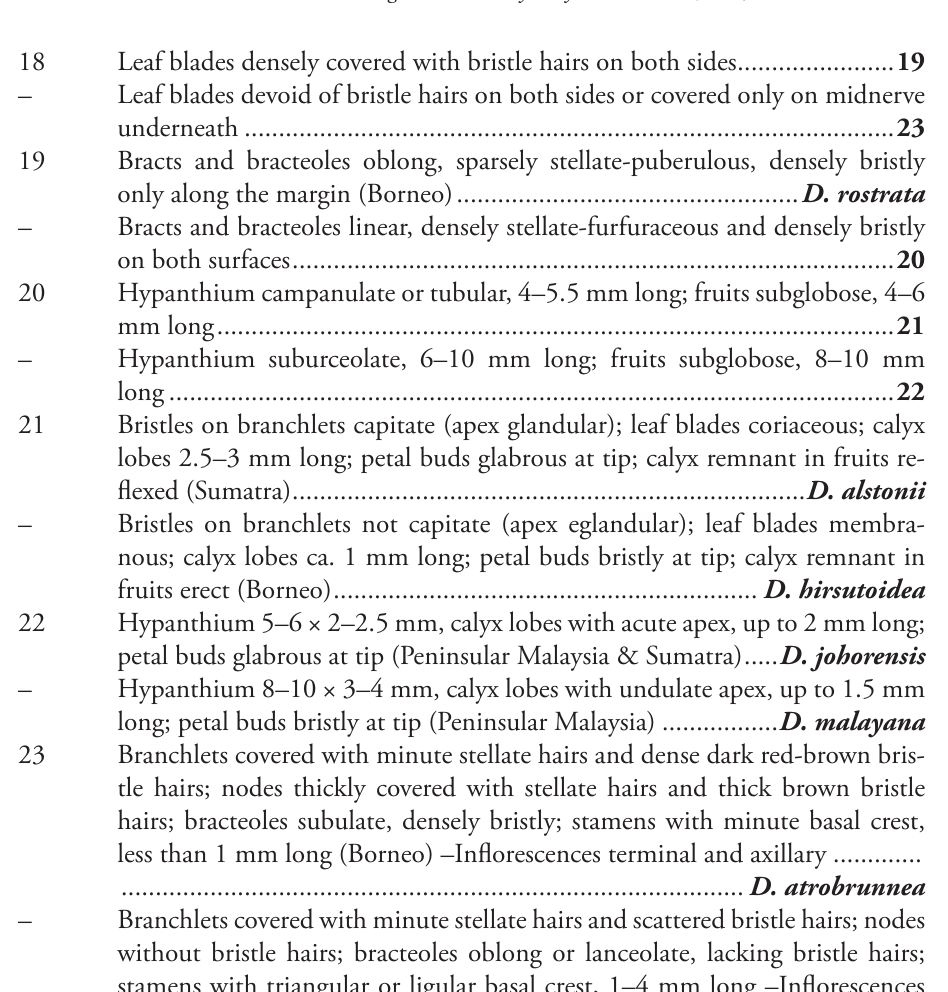
Leaf blades devoid of bristle hairs on both sides or covered only on midnerve Bracts and bracteoles oblong, sparsely stellate-puberulous, densely bristly – Bracts and bracteoles linear, densely stellate-furfuraceous and densely bristly 20 Hypanthium campanulate or tubular, 4–5.5 mm long; fruits subglobose, 4–6 – Hypanthium suburceolate, 6–10 mm long; fruits subglobose, 8–10 mm 21 Bristles on branchlets capitate (apex glandular); leaf blades coriaceous; calyx lobes 2.5–3 mm long; petal buds glabrous at tip; calyx remnant in fruits re- – Bristles on branchlets not capitate (apex eglandular); leaf blades membra- nous; calyx lobes ca. 1 mm long; petal buds bristly at tip; calyx remnant in 22 Hypanthium 5–6 × 2–2.5 mm, calyx lobes with acute apex, up to 2 mm long; petal buds glabrous at tip (Peninsular Malaysia & Sumatra) ..... D. johorensis – Hypanthium 8–10 × 3–4 mm, calyx lobes with undulate apex, up to 1.5 mm long; petal buds bristly at tip (Peninsular Malaysia) ................. D. malayana 23 Branchlets covered with minute stellate hairs and dense dark red-brown bris- tle hairs; nodes thickly covered with stellate hairs and thick brown bristle hairs; bracteoles subulate, densely bristly; stamens with minute basal crest, less than 1 mm long (Borneo) –Inflorescences terminal and axillary ............. – Branchlets covered with minute stellate hairs and scattered bristle hairs; nodes without bristle hairs; bracteoles oblong or lanceolate, lacking bristle hairs; stamens with triangular or ligular basal crest, 1–4 mm long –Inflorescences 24 Leaf blades subcoriaceous, with prominent nervation; bracteoles 10–15 × ca. 2 mm; hypanthium campanulate, 8–10 × 5–7 mm, calyx lobes with acute apex, ca. 3 mm long; petal buds without bristle hairs at apex; fruits urceolate, – Leaf blades membranous, without prominent nervation; bracteoles ca. 3.5 × 1 mm; hypanthium tubular, ca. 4 × 2 mm, calyx lobes with obtuse apex, ca. 1 mm long; petal buds bristly at apex; fruits ovoid, 5–6 × 3–3.5 mm (Borneo) ... 25 Bristle hairs on branchlets, petioles and hypanthium curved; leaf blades mem- branous, hirsute, covered with curved bristle hairs on both surfaces, 9.7–12 cm long; hypanthium campanulate, 5–6 mm long, calyx lobes 3–4 mm long; Bristle hairs on branchlets, petioles and hypanthium straight; leaf blades